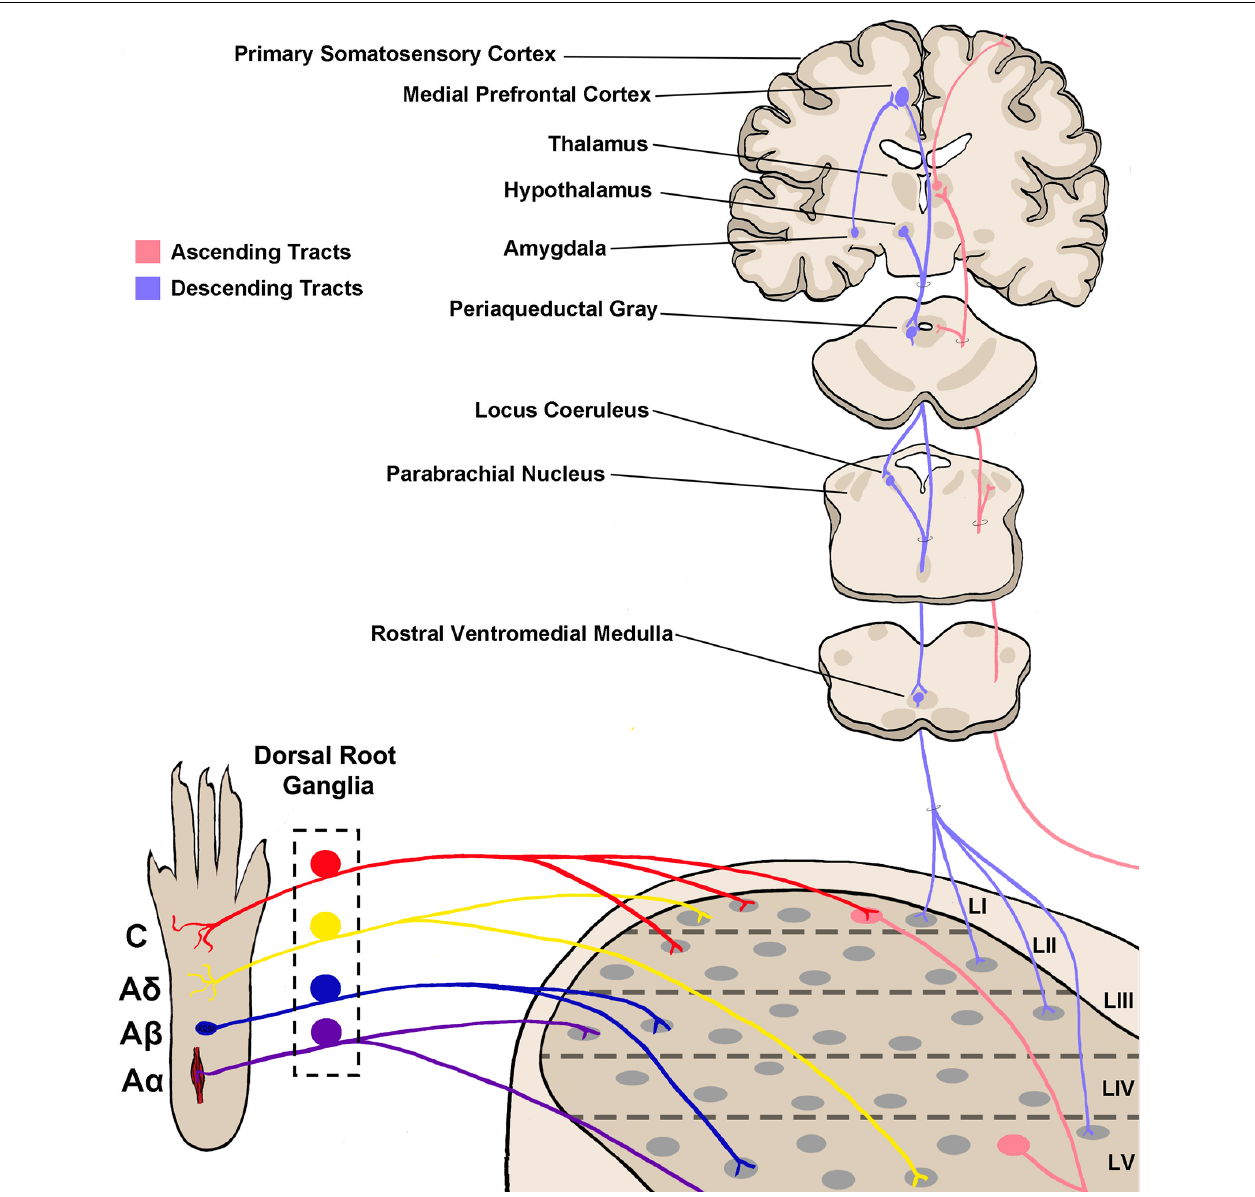
FIGURE 1 | Somatosensory circuitry from the periphery to the brain. Somatosensory information is first transmitted into the spinal dorsal horn by primary afferent neuron fibers, which extend from peripheral tissue into the spinal cord and synapse onto neurons within the dorsal horn. There are four main types of primary afferent fiber, separated by transduction velocity, and each type (A α , A β , A δ , C) shows some selectivity in somatosensory modality transmitted and synapses into different laminae as shown here (Roberts and Elardo, 1986; McGlone and Reilly, 2010; Koch et al., 2018). This produces selectivity in the modality processed in each lamina of the dorsal horn. Projection neurons within lamina I and V send axons up to the brain via ascending tracts including the spinothalamic tract and dorsal column–medial lemniscal tract (not shown in the figure; Willis, 1985; Niu et al., 2013). Briefly, axons decussate at the spinal level, then ascend on the contralateral side towards the thalamus. Some projections terminate within other brainstem regions including the parabrachial nucleus and periaqueductal gray. Descending tracts originate from several brain regions including the medial prefrontal cortex, hypothalamus, and amygdala, and project first to the periaqueductal gray (Gebhart, 2004; Huang et al., 2019). From here, descending projections then synapse within the rostral ventromedial medulla (RVM), and join with locus coeruleus (LC) descending projections. RVM/LC projection targets including the superficial dorsal horn and lamina V (D’Mello and Dickenson, 2008; François et al., 2017).